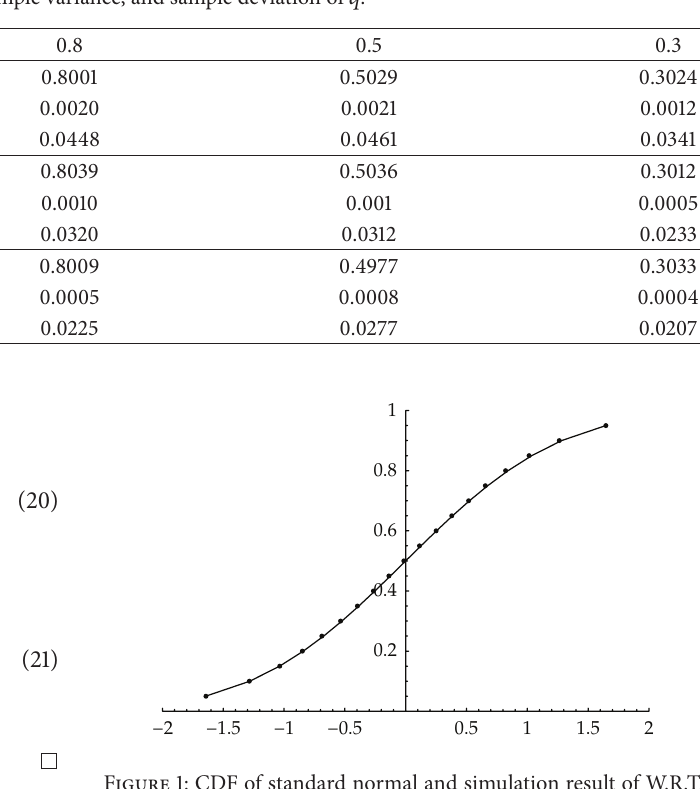
Figure 1: CDF of standard normal and simulation result of